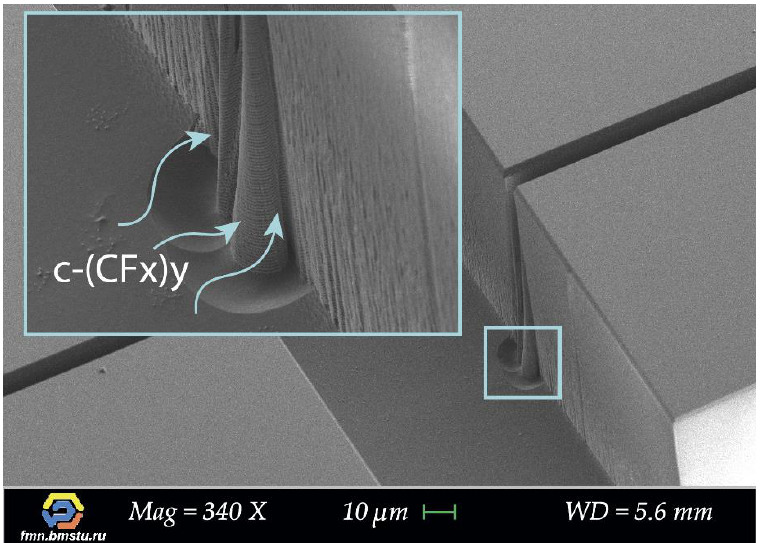
Figure 13. SEM images of “build-up” defects and etched groove formation in the area of intersection target microstructures and 20 μm wide transverse crossing auxiliary lines.